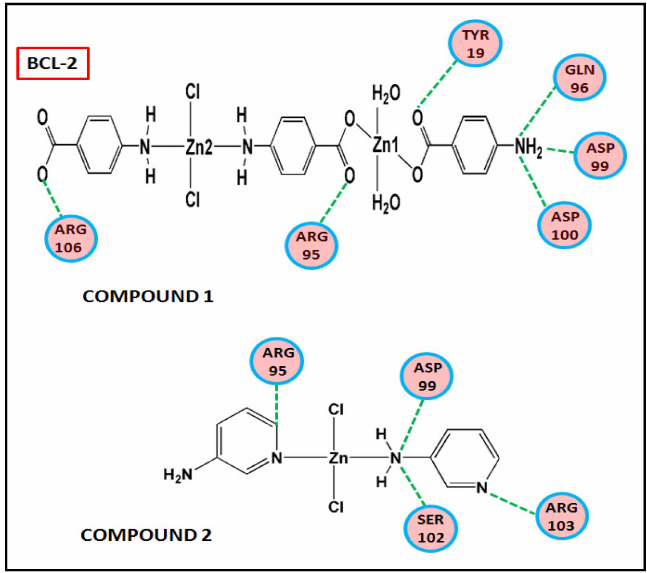
Figure 17. Chemical interactions of modelled fragments of the compounds with BCL-2 have been represented with compounds’ atoms and interacting amino acid residues.